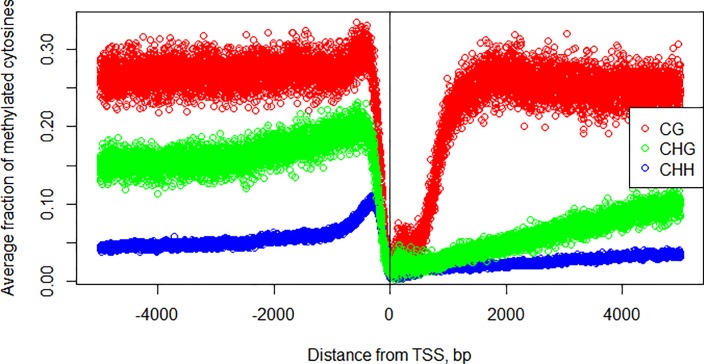
Methylation around transcription start site in rice in different sequence contexts.Red–CG, green—CHG, blue–CHH, where H denotes A, C or T nucleotide.